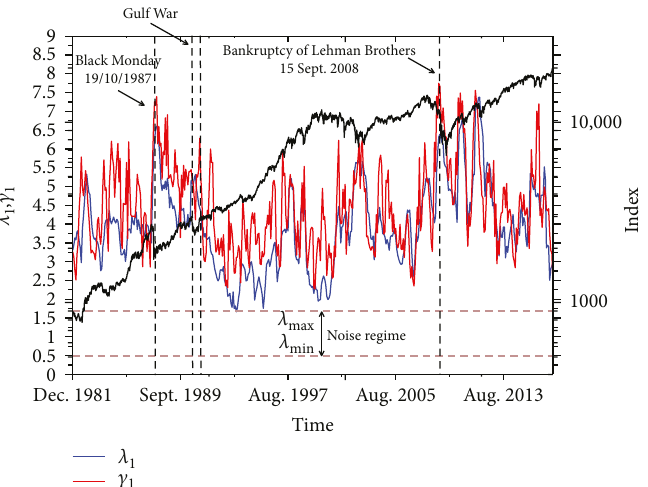
Figure 10: The blue line displays the time dependence of the largest eigenvalue λ representing daily returns of the 9 companies of Figure 9 in a rolling window of size s = 100 trading days. The red line displays the largest eigenvalues γ of an analogous rolling window matrix composed of the ρ q s coe ffi cients as de fi ned by (11) taking q = 2 1